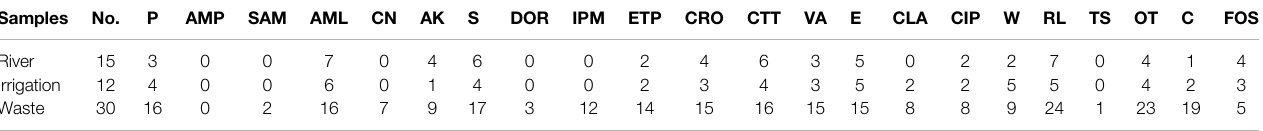
TABLE 2 | Distribution of antibiotic-resistant Listeria monocytogenes isolates recovered from environmental waters. Samples